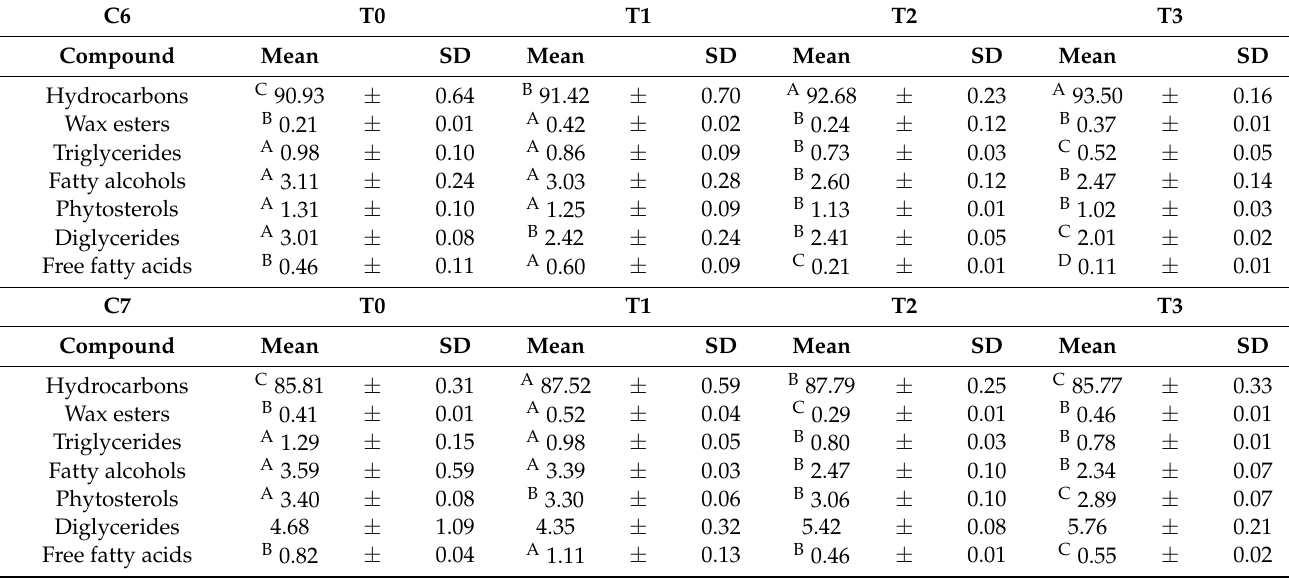
Table 4. Lipid class compositions (g/100 g of lipids) of distilled samples (C6 and C7) at the different assay times. C6 T0 Compound